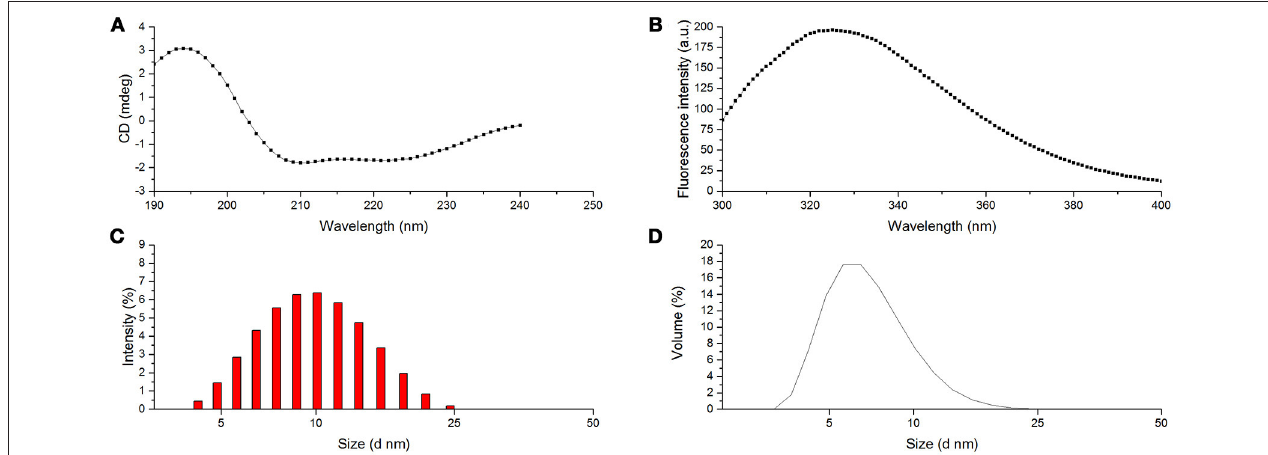
FIGURE 5 | Structural characteristics of BRP. (A) CD spectra of BRP; (B) Fluorescence spectra of BRP; (C) PSD of BRP (intensity); (D) PSD of BRP (volume).